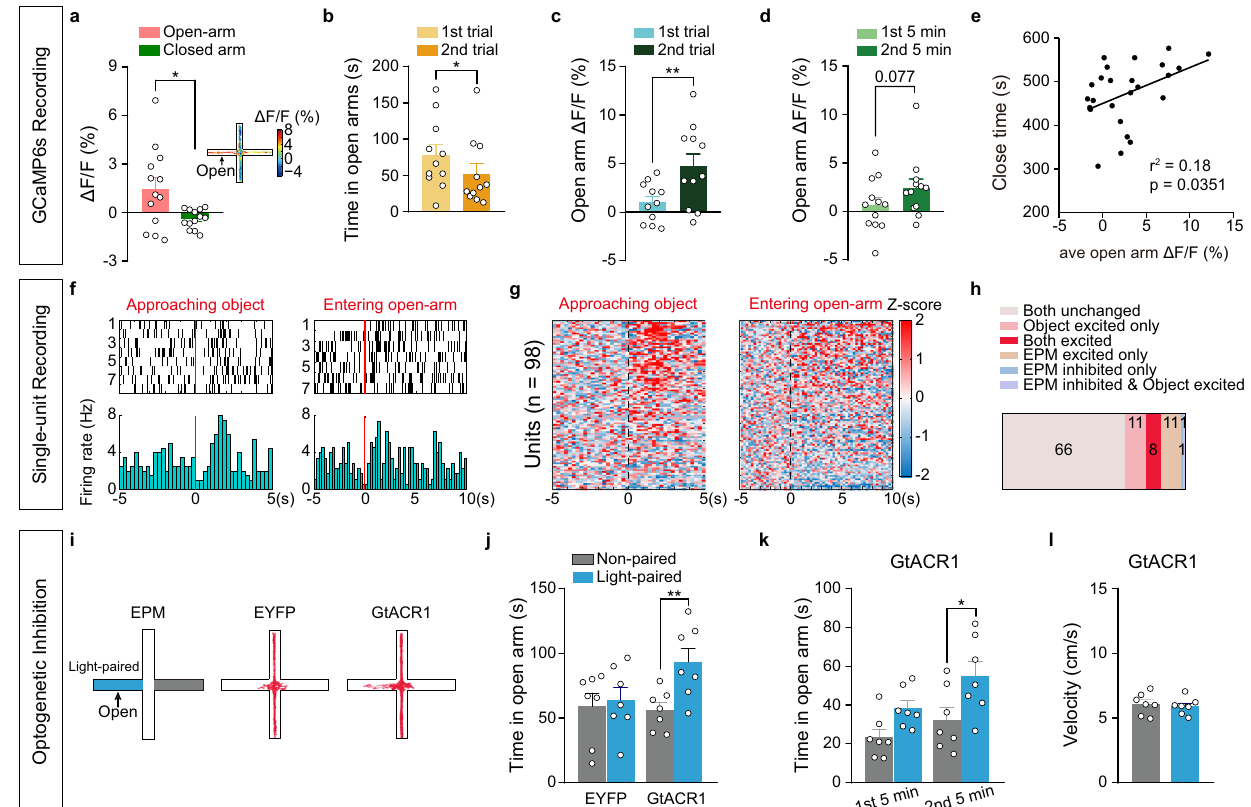
Fig. 5 | Progressive engagement of AHN Vgat+ neurons on EPM. a – e Recording of AHN Vgat+ GCaMP6s signals on EPM. a Average Δ F / F values in EPM open and closed arm for the fi rst trial with the a heatmap representation of EPM Δ F / F value in an example (right). n =13 mice. Two-tailed paired t test p =0.048. b , c Average open- arm time ( b ) and Δ F / F values ( c ) in the fi rst or second trial. n =11 mice. Open-arm time, Wilcoxon matched-pairs signed rank test, p =0.01; Δ F / F , two-tailed paired t test, p =0.006. d Average Δ F / F values in the fi rst or second 5min of the fi rst trial. n =12mice. e Correlationbetweenaverageopen-arm Δ F / F valueandthetimespent in the closed arm. n =14 mice. Pearson correlation. f – h Single-unit recordings of AHN neurons. f Raster plot (top) and the average (bottom) of the fi ring rates of an example single-unitalignedto the onset of the objectapproach (left) and entering